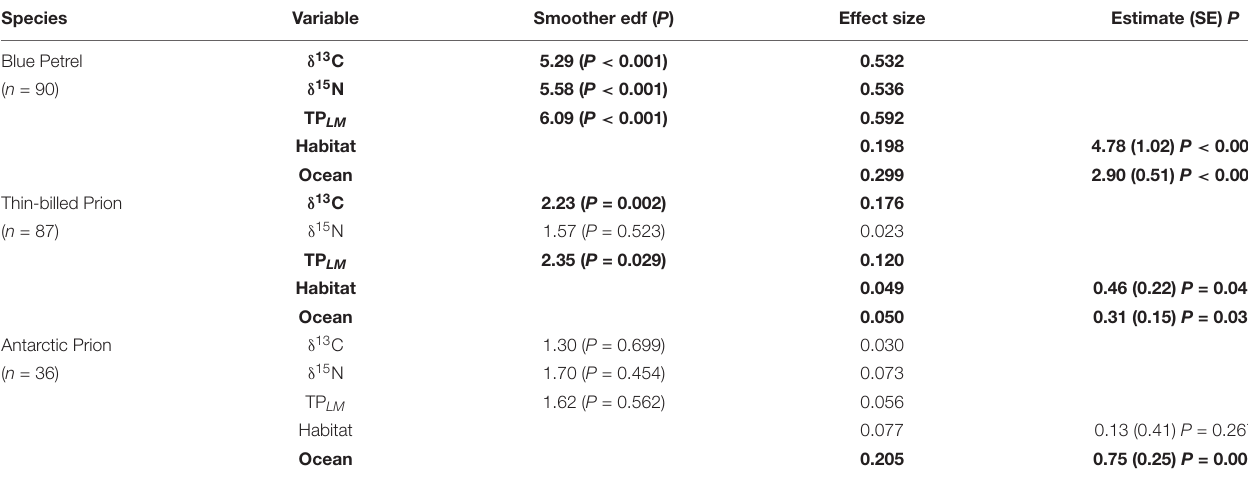
TABLE 4 | Generalized Additive Model (GAM) results for feather mercury values, separately for the species, as a function of distribution ( δ 13 C, habitat), trophic position ( δ 15 N, TP LM ), and ocean basin (Atlantic, Indian, or Pacific). Species Variable Smoother edf ( P ) Effect size Estimate (SE) P Blue